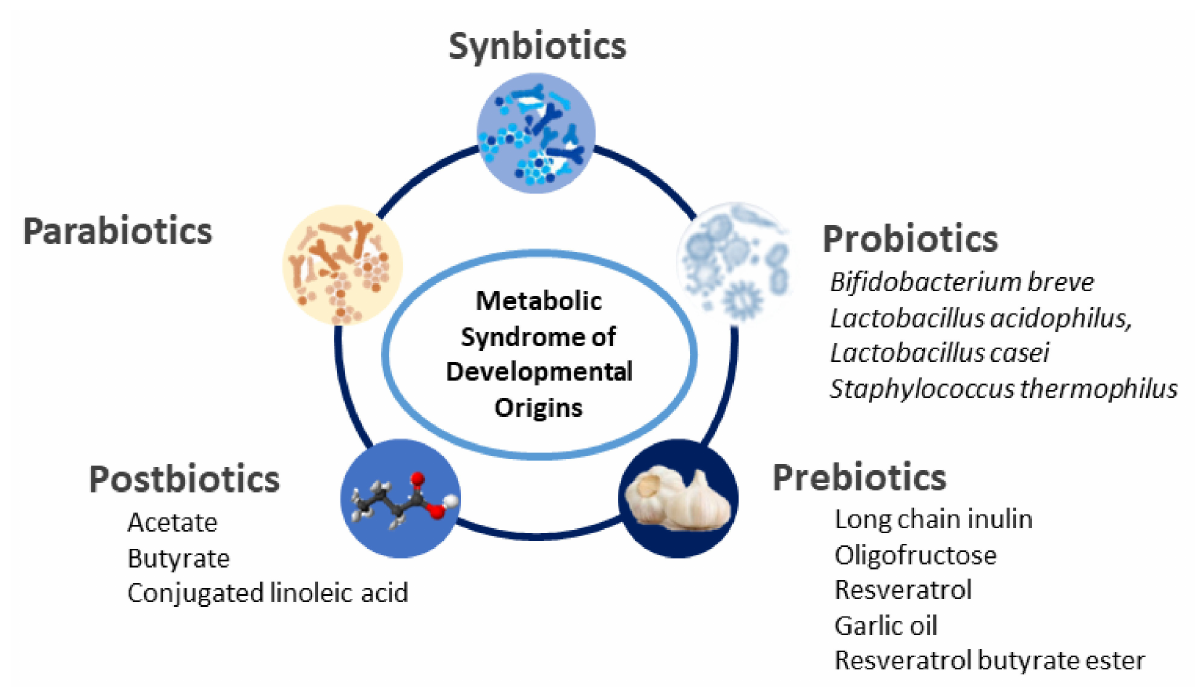
Figure 2. A summary of the currently available reprogramming interventions for metabolic syndrome of developmental